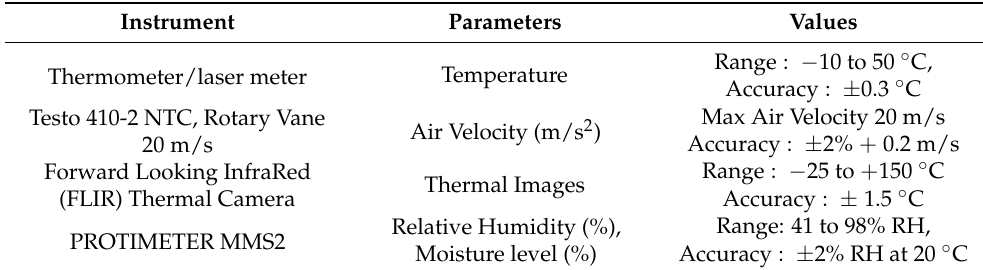
Table 1. Instrument used for measuring temperature and relative humidity.